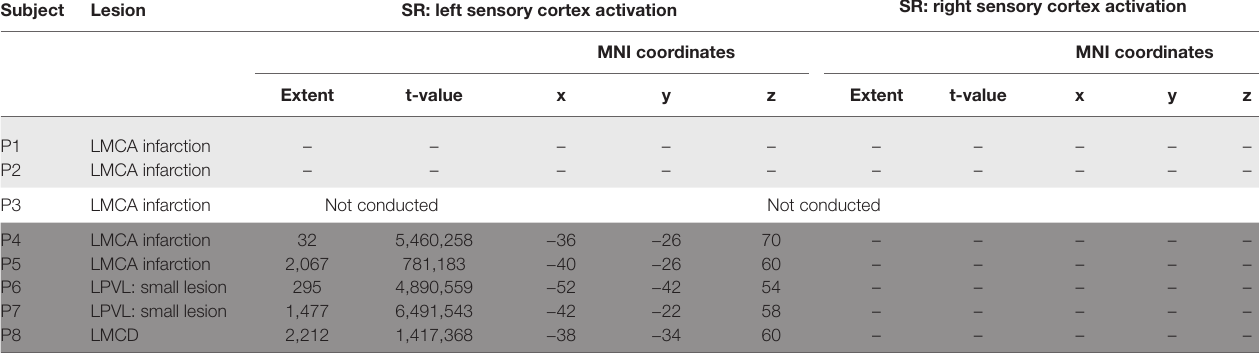
TABlE 4 | Activation in the primary sensory cortex during SR task.